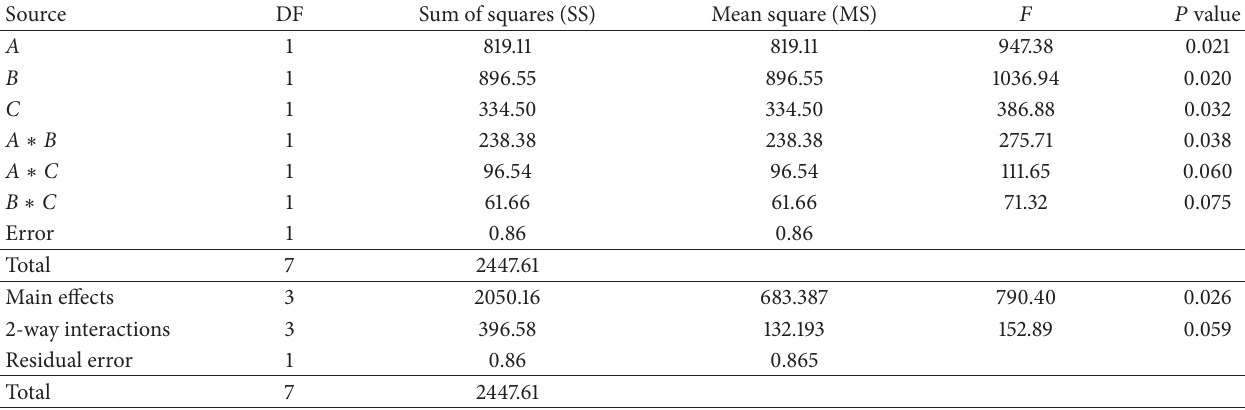
Table 7: Analysis of variance (ANOVA) for removal efficiency (%).